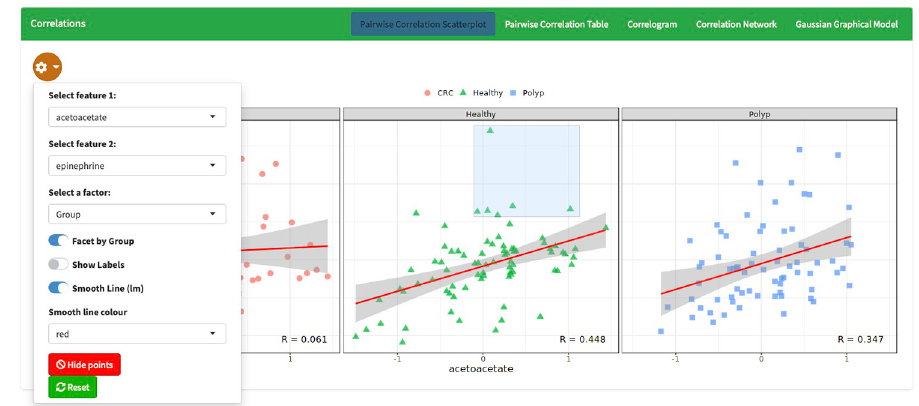
Fig 3. Screenshot of the “Correlation Analysis” panel showing an interactive scatterplot of pairwise correlation between acetoacetate and epinephrine in the three different study groups “CRC”, “Healthy” and “Polyp”. ST000284 example data were used to create these